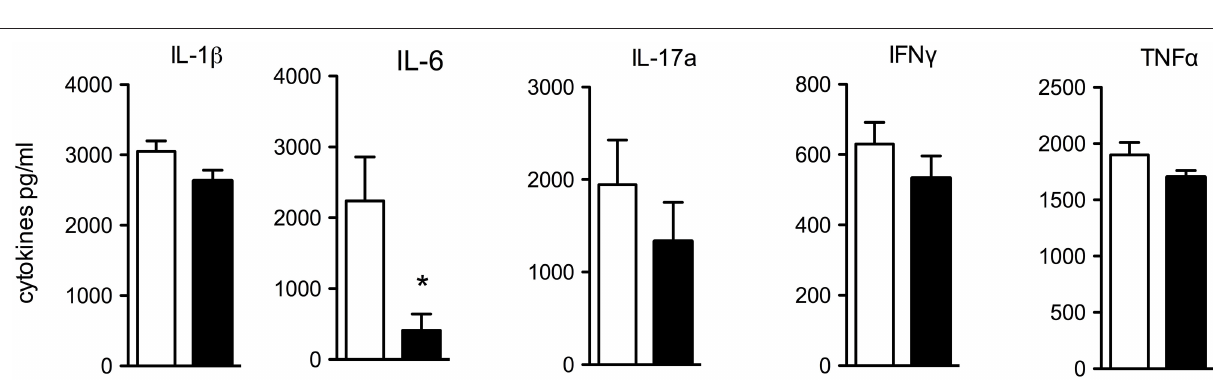
FIGURE 3 | Spontaneous cytokine release from colon biopsies. Transmural biopsies from macroscopically non-inflamed areas of the proximal colon were taken at the time of colon removal during chronic colitis and incubated in RPMI for 24h. Supernatants were tested for spontaneous cytokine release. Cytokines were measured by multiplex array and Elisa (IL-6). Data are expressed as the mean (SEM). Open bars: IL-10KO mice ( n = 10), closed bars: IL-10KO/IL-37tg mice ( n = 5). * p < 0.05. Statistical significance tested with